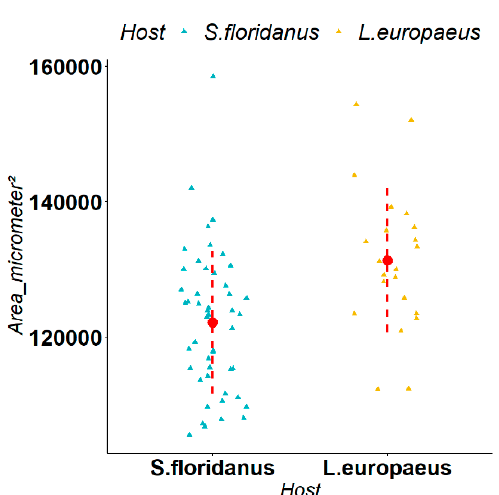
Figure 3. Comparison of the spicula of Obeliscoides cuniculi in Lepus europaeus and Sylvilagus floridanus (measurements shown in μ m 2 ). The triangles represent the single observations, the red dots represent the average values, while the red dashed lines represent the standard deviation.